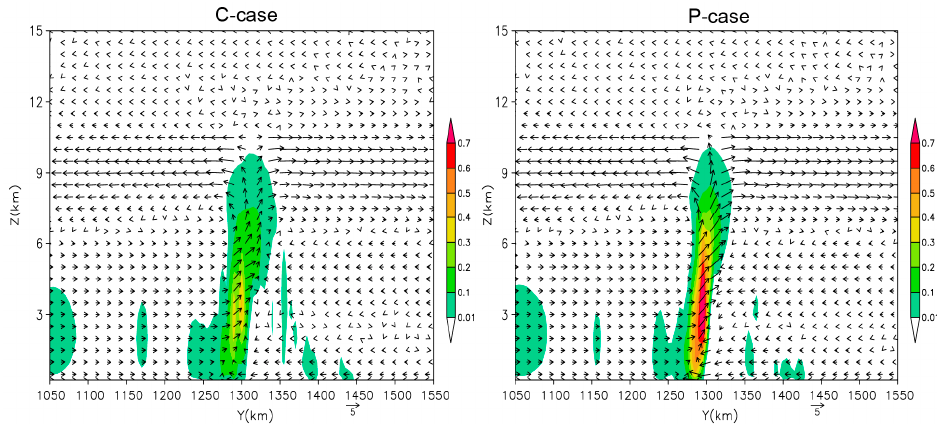
Figure 16. Vertical cross sections of zonal mean Vertical Water Vapor Flux ( | w · q | / g , shading, Units: g · cm − 1 · hPa − 1 · s − 1 ) and cross-front wind perturbation vectors ( v (cid:48) , w ) at t = 21 h for ( a ) typical continental C-case and ( b ) polluted continental P-case. Only a 500 km × 15 km of the domain is presented.